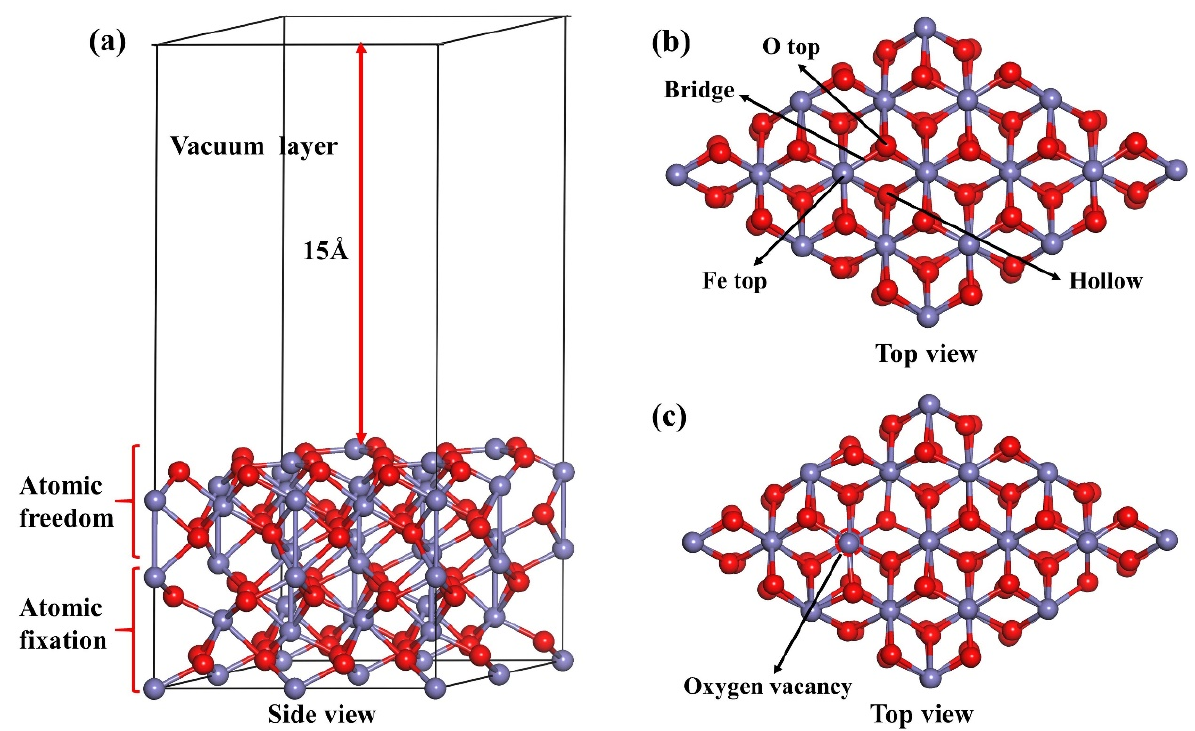
Figure 2. ( a ) The geometrically optimized slab model of α -Fe 2 O 3 (001) surface; ( b ) the adsorption site on pure α -Fe 2 O 3 (001) surface; and ( c ) the adsorption site of oxygen vacancy α -Fe 2 O 3 (001) surface.